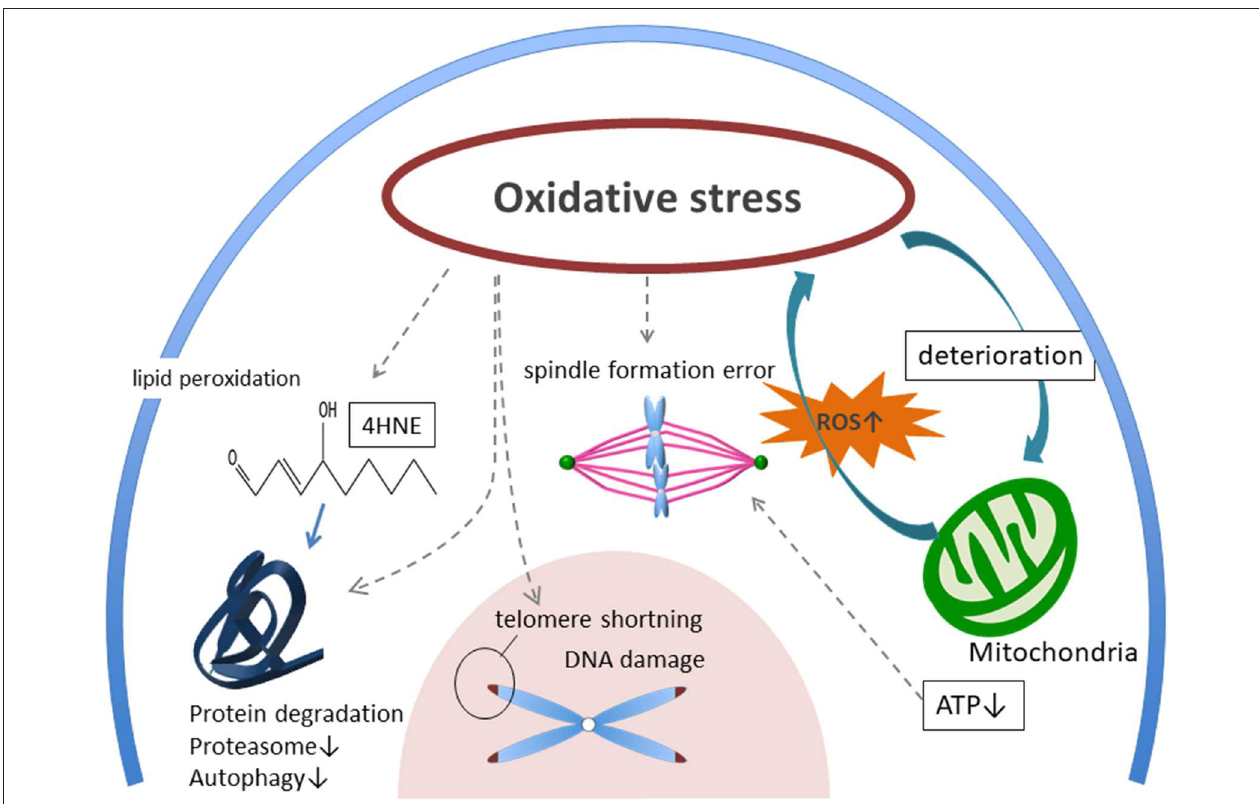
FIGURE 1 | Possible mechanism of aged oocyte deterioration with accumulating oxidative stress. External ROS, AGEs, and accumulation of internal ROS from mitochondria are burdening oocytes as oxidative stress (OS). Then, OS induces deterioration of mitochondria, telomere shortening, spindle formation error, DNA damage, and protein degradation. ROS, reactive oxygen species. AGEs, glycation end-products. RAGE, receptor for advanced glycation end-products. 4-HNE,